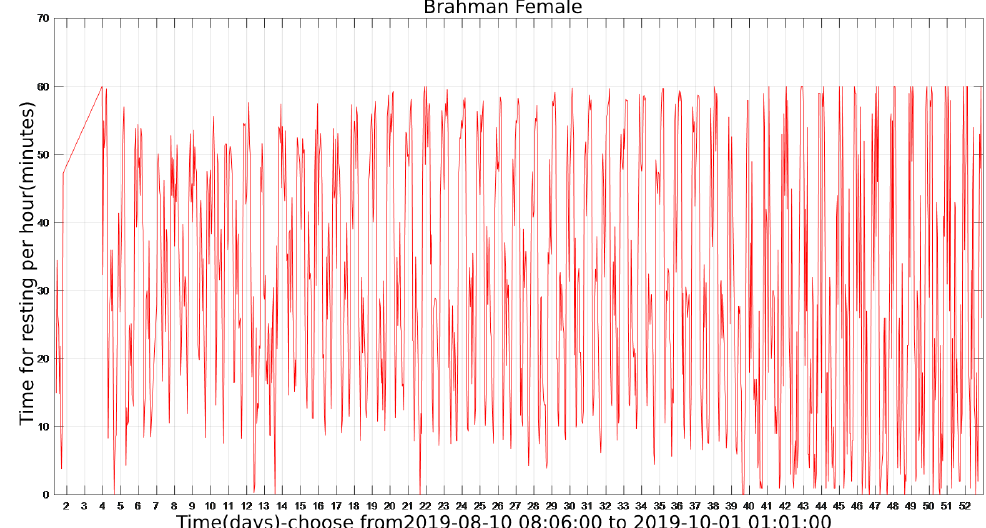
Figure 3. The resting time of Brahman Female during the whole sample period.